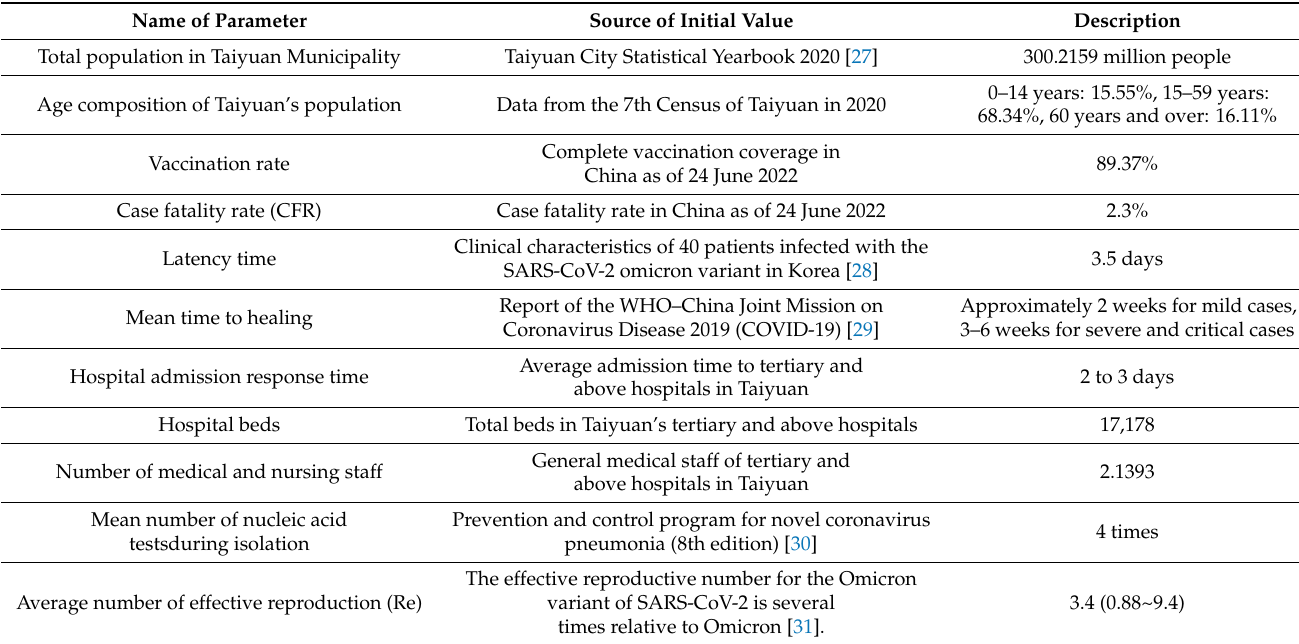
Table 3. Model parameters for transmission and control model of the Omicron